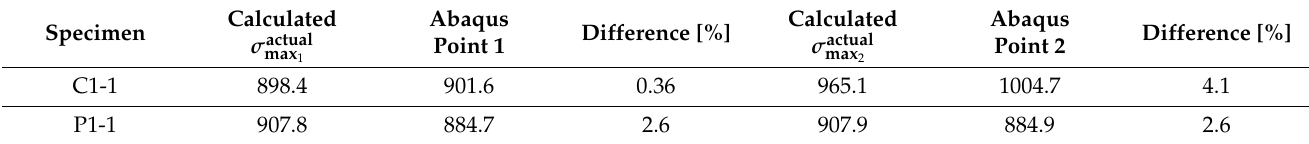
Table 5. Comparison of the maximal stresses for the specimen C1-1 and